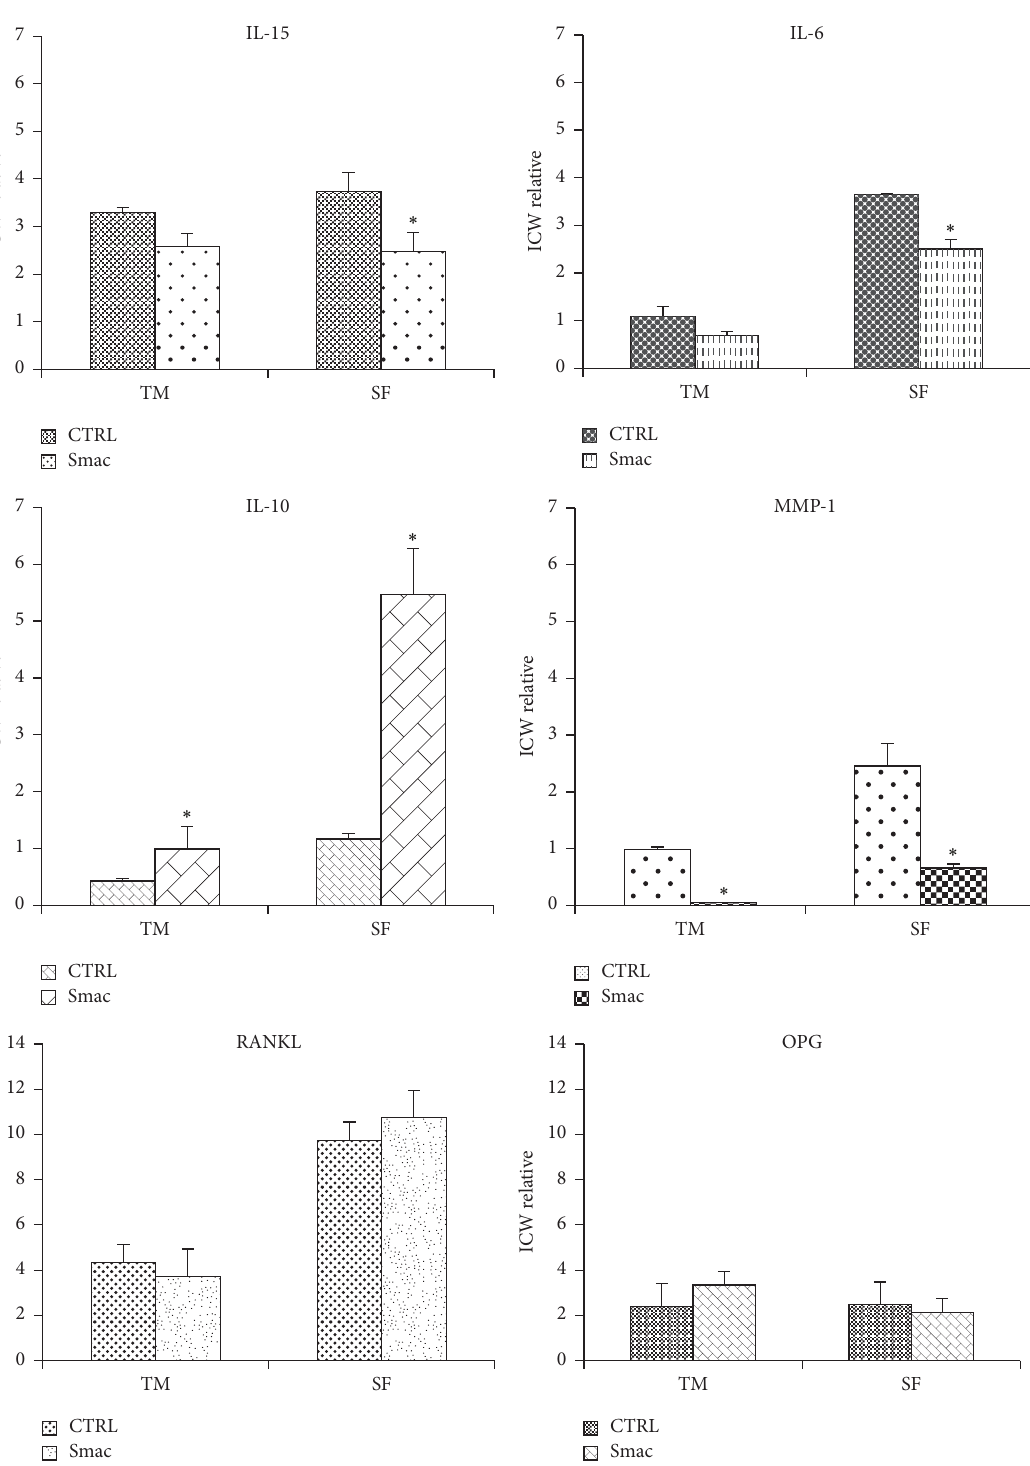
Figure 6: Cytokine modulation in RA-FLSs. IL15: RA-FLSs were grown in tissue medium (TM) or in synovial fluid (SF) for 5 days. Smac127 (15 𝜇 M) was added for 24 hrs. The data were generated with Odyssey infrared platform. In Cell Western with 800 channels we detected the cytokine production. Data are expressed as In Cell Western relative data (ICW relative). We analysed the production of IL-15, IL-6, IL-10, MMP-1, RANKL, and OPG. The histograms summarize the mean ± SD of the ten independent experiments. ∗ 𝑝 < 0.05 versus untreated